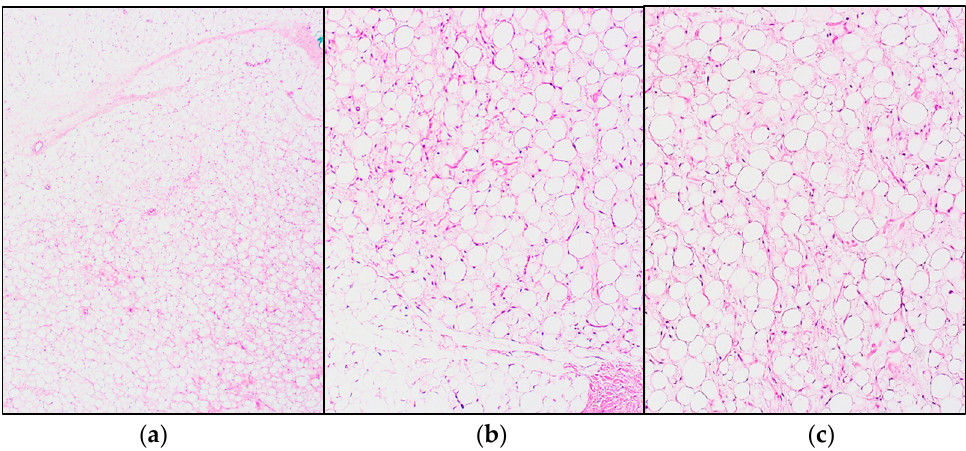
Figure 1. Histopathology of a lipoblastoma: ( a ) Overview showing lobulated sheets of adipocytes, separated by a fibrovascular septum (hematoxylin and eosin (H&E) staining); ( b , c ) Close up showing an image of the adipocytes with a spectrum of maturation, ranging from spindled mesenchymal cells to lipoblasts to mature adipocytes (H&E staining).